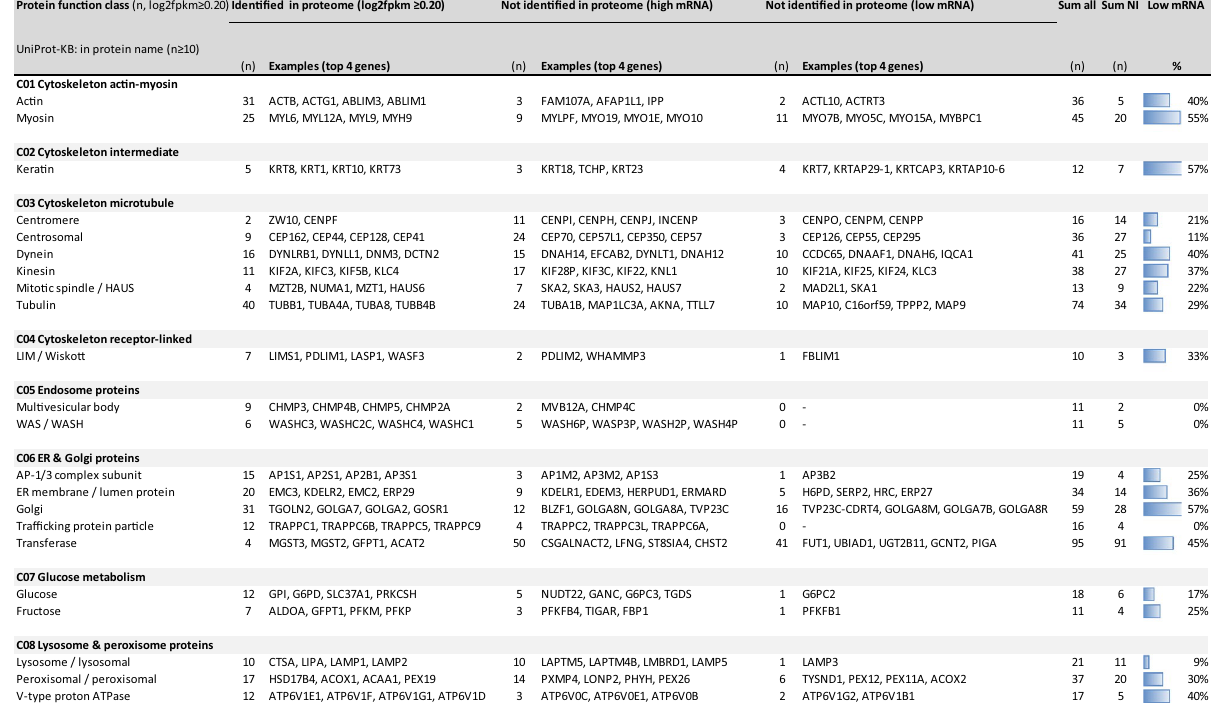
Table 3. Subgroup analysis of non-identified proteins (n = 9,721) of the relevant PLT/MGK transcriptome. Per function class (C 01 –C 21 ), the transcriptome database was searched for common elements in protein names (’actin’, ’myosin’), and frequency was recorded as identified in the proteome, or not identified with a separation into high mRNA (log2fpkm > 1.00) or low mRNA (log2fpkm 0.20–1.00). Top-4 of most abundant transcripts were listed per element. Further indicated per element: numbers of all transcripts (Sum all), and numbers of transcripts not identified in proteome (Sum